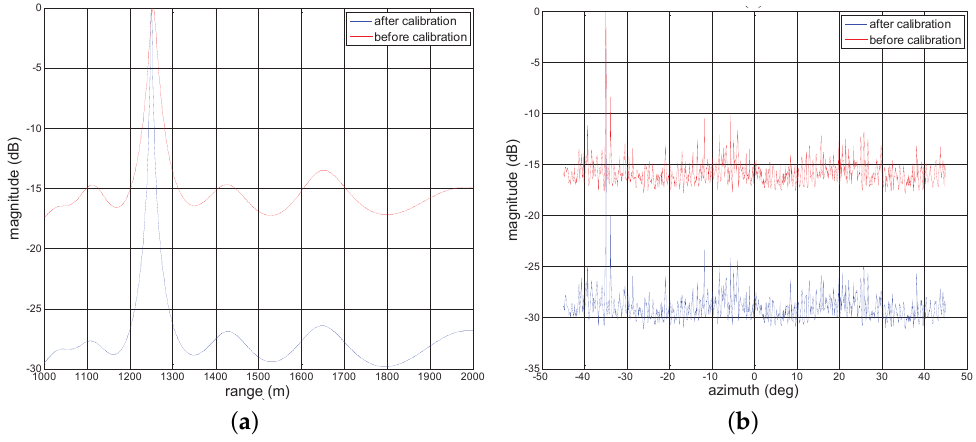
Figure 7. One-dimensional MVDR spatial spectrums for a source with estimated location ( 1251m, − 35 ◦ ) under SNR = 20 dB, ( a ) θ = − 35 ◦ ; ( b ) r = 1251m.